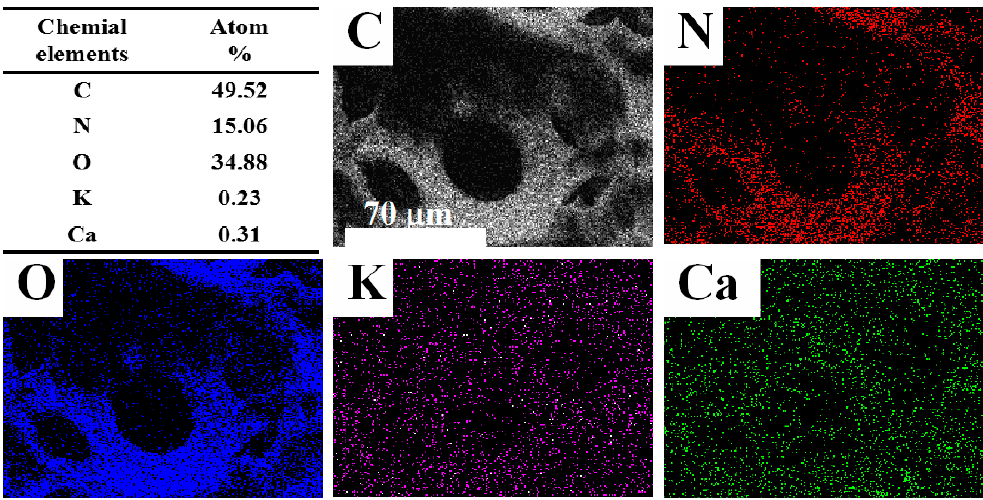
Figure 10. The mapping images and EDS chart of Ca-BDC/P(AM- co -HEMA)HIPE composite.